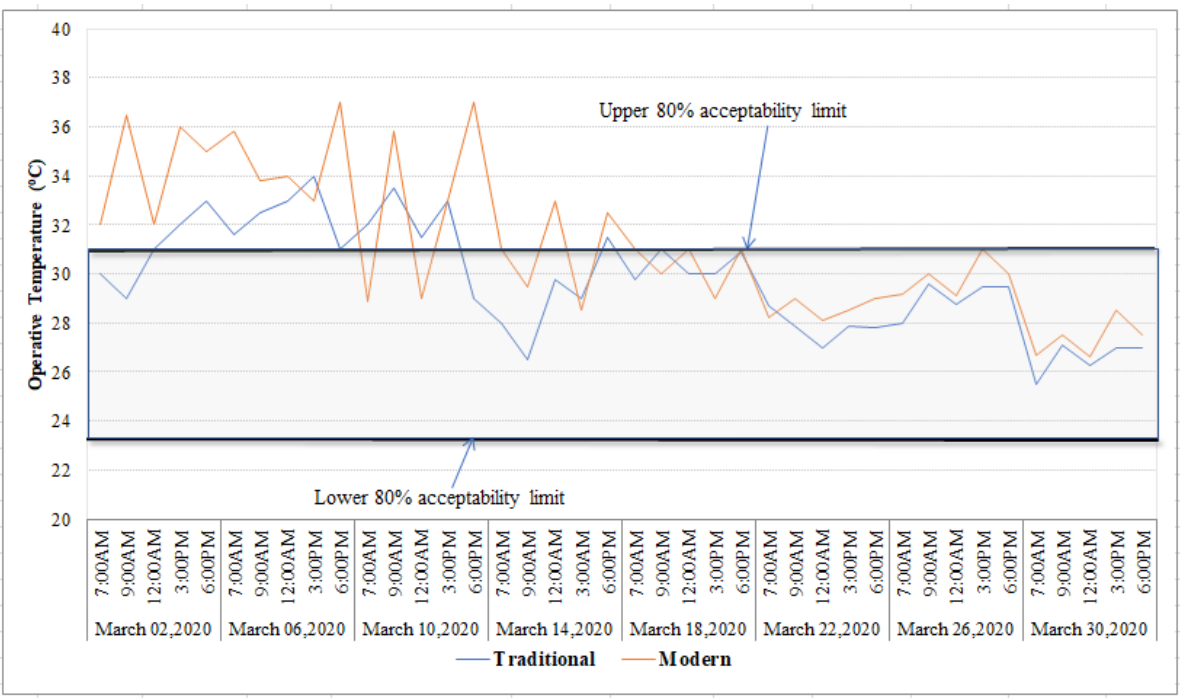
Figure 24. Indoor thermal comfort evaluation from March 2020.